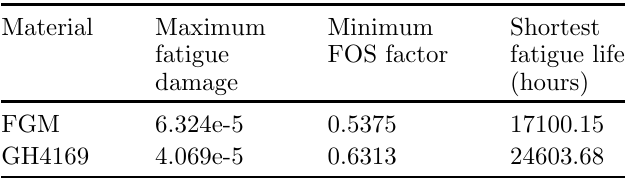
Table 10. Comparison of turbine disc fatigue character- istics for two materials in maximum